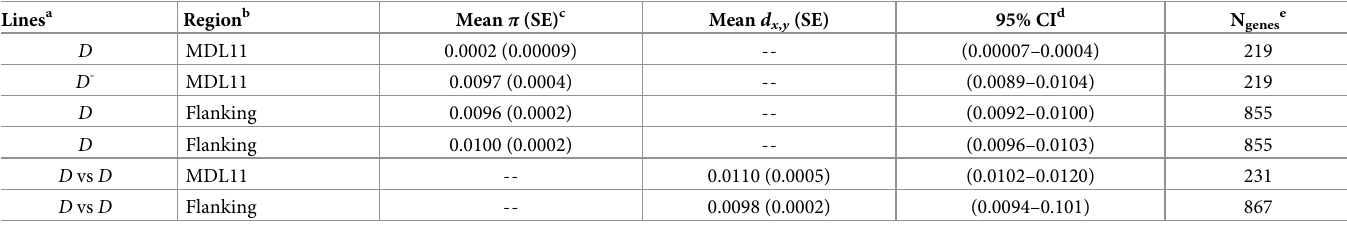
Table 1. Nucleotide diversity across LG11 in the IM Mimulus guttatus